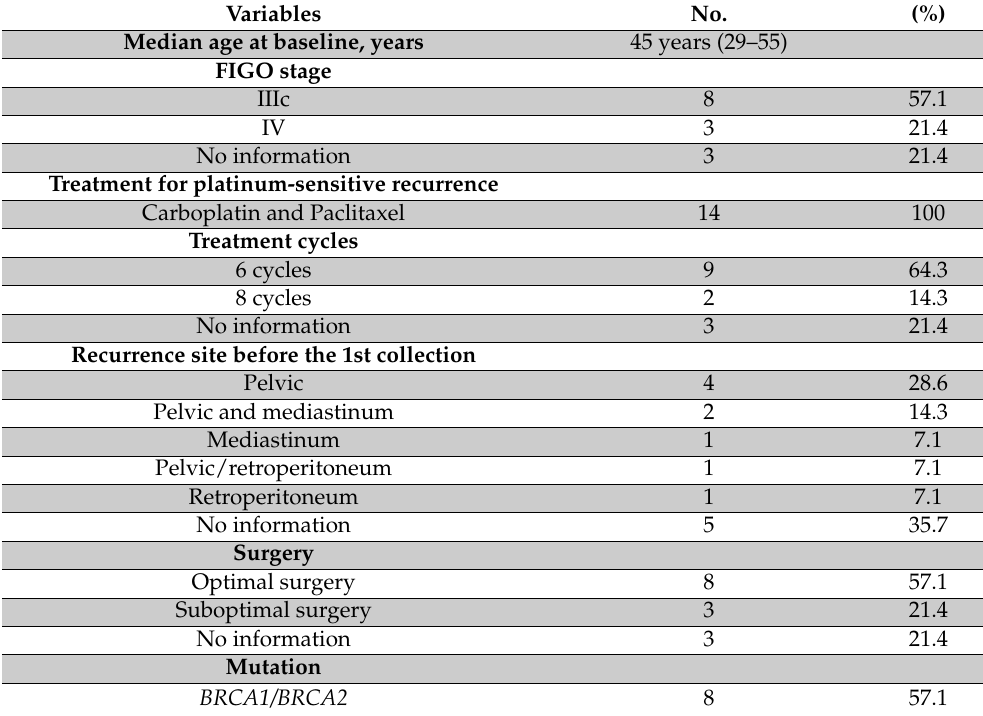
Table 1. Clinic-pathological variables in patients with high grade ovarian cancer.